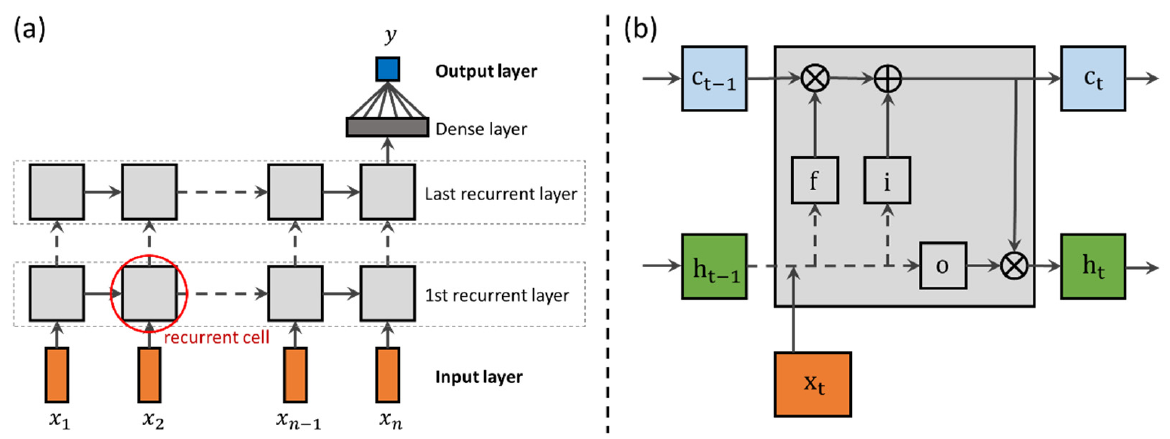
Figure 1. ( a ) Schematic diagram of a recurrent neural network. The input data ( x t ) for each time step ( t ) is input to each cell in the first recurrent layer, and the output of each recurrent cell is supplied to the cell of the next time step and the next recurrent layer. The output of the last recurrent layer in the last time step is supplied to the dense layer to calculate the final prediction ( y ); and ( b ) the internal operation of an LSTM cell, where f stands for the forget gate, i for the input gate, and o for the output gate. Note that x t denotes the input at time step t , c t denotes the cell state, and h t denotes the hidden state.